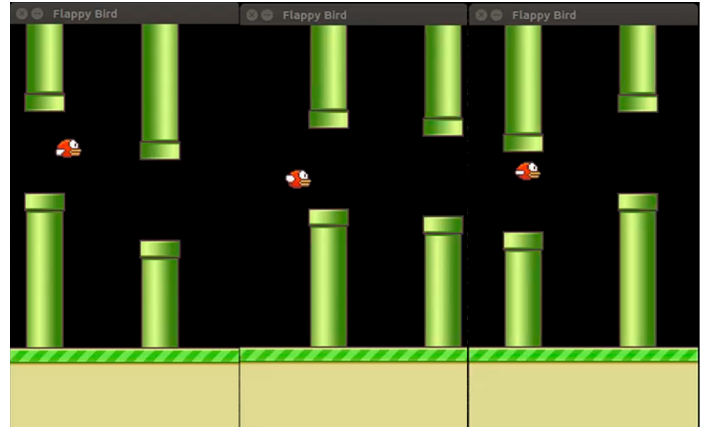
Figure 14. The Flappy Bird game.